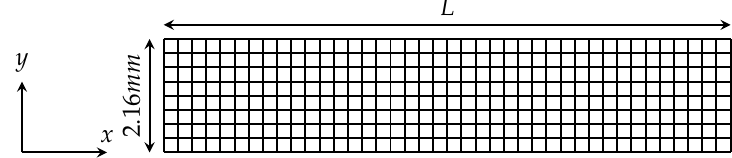
Figure 5. Representative part of laminate modelled in